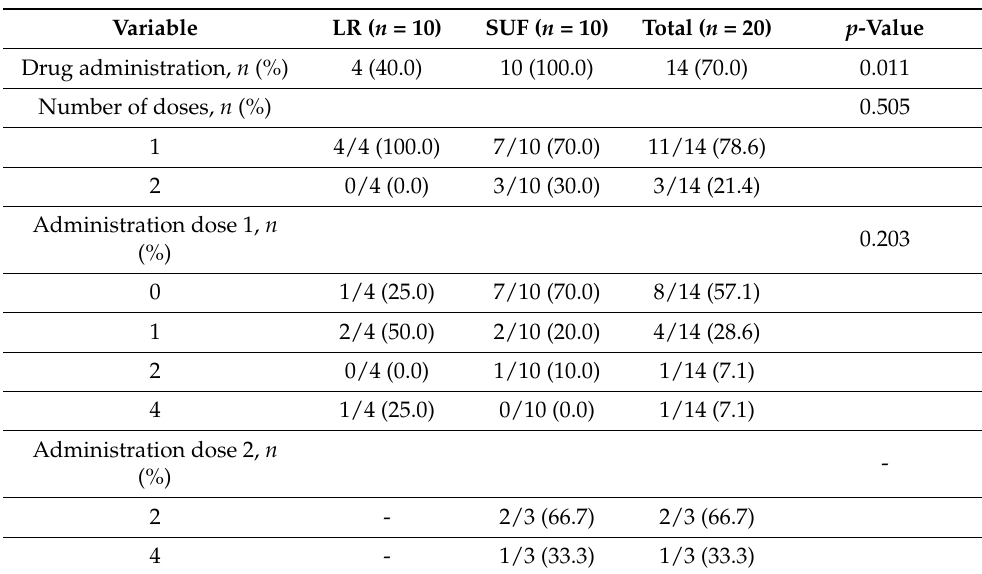
Table 2. Methadone administration by group (LR vs. SUF).